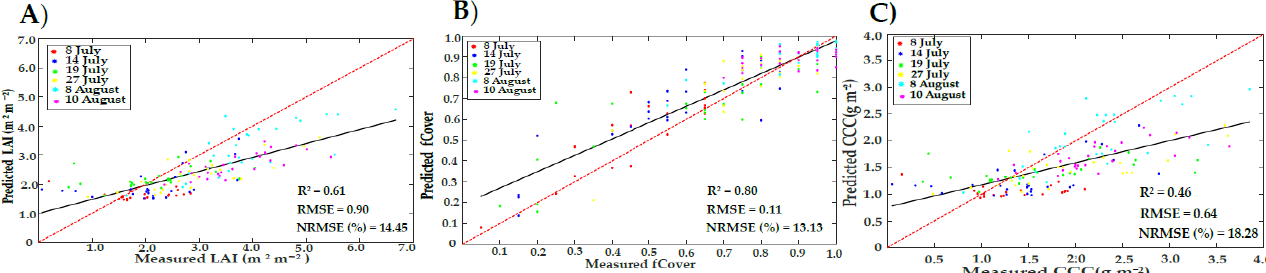
Figure A1. The distribution of measured leaf area index (LAI) and leaf chlorophyll content (LCC) using all data (156 samples).